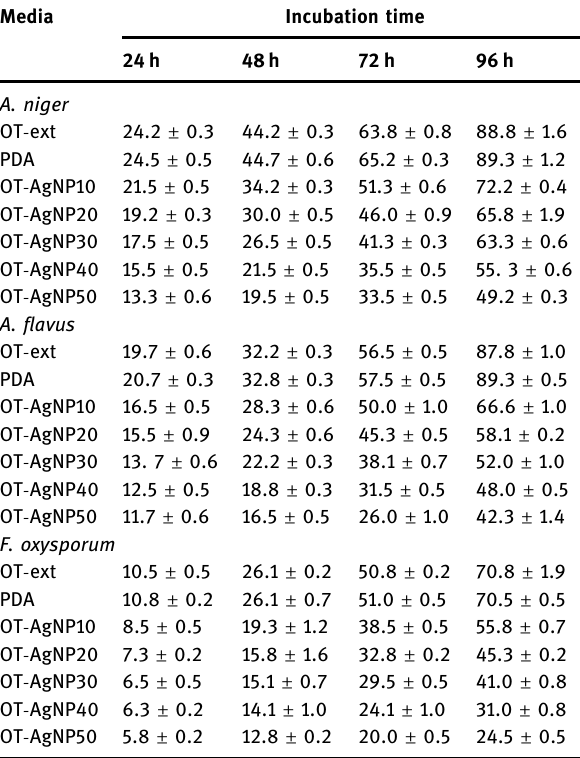
Table 2: Mycelial zone ( mm ) of A. niger , A. fl avus , and F. oxysporum cultured in PDA media without and with various OT - AgNP concentrations for 96